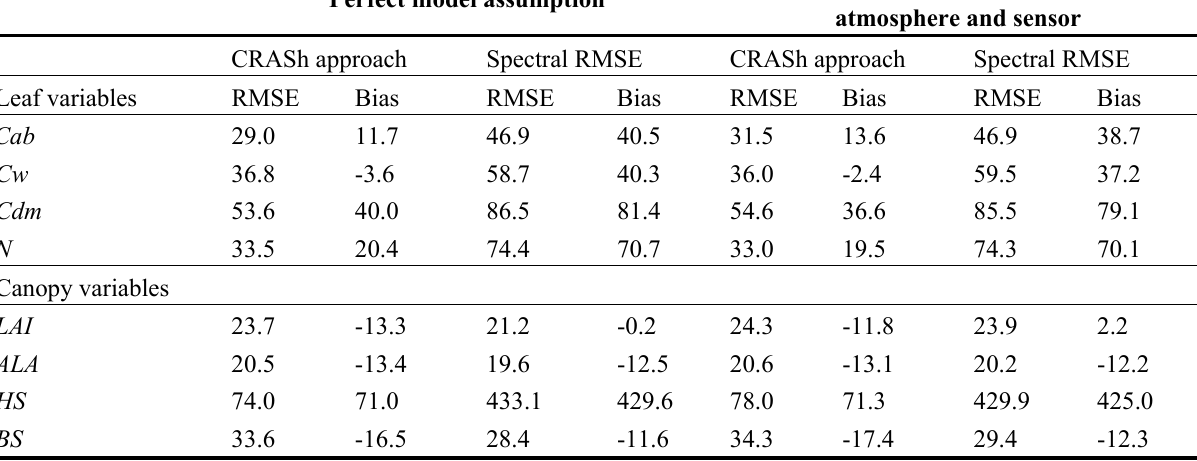
Table 5. Model inversion results based on synthetic data set for CRASh approach and minimization based on spectral RMSE. All values are given in %. Results for Cbp were not included as these showed values close to infinity due to fixing Cbp to value close to